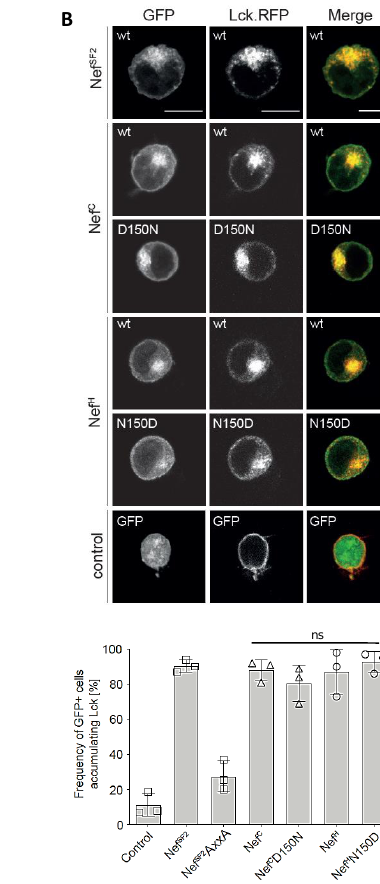
Figure 5. The D150N substitution restores the ability of Nef H to downregulate SERINC5 and CD4. ( A ): the effect of different Nef proteins on the surface expression level of SERINC5, CD4 and MHC-I. Relative cell surface levels in cells co-transfected with the indicated nef sequences expressed upstream of an IRES2-eGFP cassette to allow the exclusive gating of Nef-expressing cells. Residual surface expression was measured as median fluorescence intensity, and values are expressed as a percentage of the Nef Fs control. The well-characterized mutation of the di-leucine sorting signal in the context of the Nef LAI protein was also tested as a control. Error bars represent s.d. from three biological replicates, an unpaired two-tailed t-test, *** p > 0.0001 (Graphpad) – ( B) : representative confocal micrographs and quantification of Lck retargeting in Jurkat (TAg) T cells co-expressing the indicated Nef variants and mutants as a fusion protein with eGFP and Lck as a fusion protein with RFP. The quantification of total cells shows a dense accumulation of Lck at the trans -Golgi network when counting at least 100 eGFP-expressing cells per condition (plotted as %). Nef SF2 and the corresponding loss-of-function mutant AxxA were used as controls. Scale bar: 10 µm. Bars represent the mean ± s.d. (biological triplicates), unpaired two-tailed t-test, *** p < 0.001, **p < 0.01 (GraphPad).